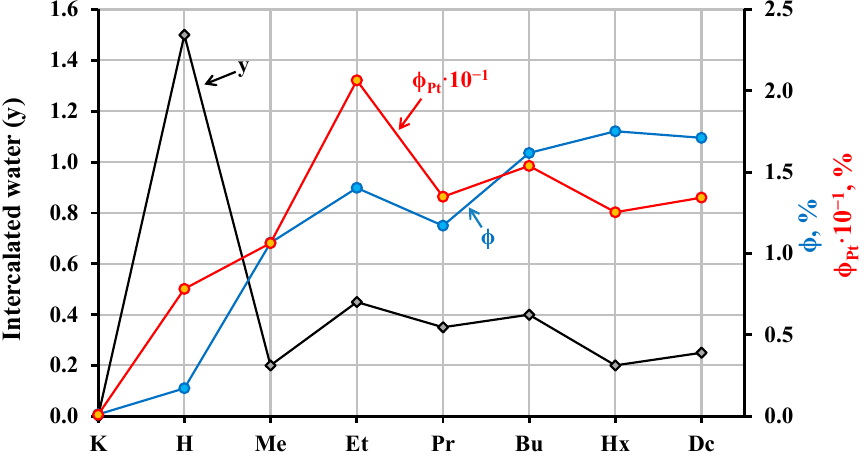
Figure 10. Correlation between apparent quantum efficiency ϕ and hydration degree of the sam- ples.